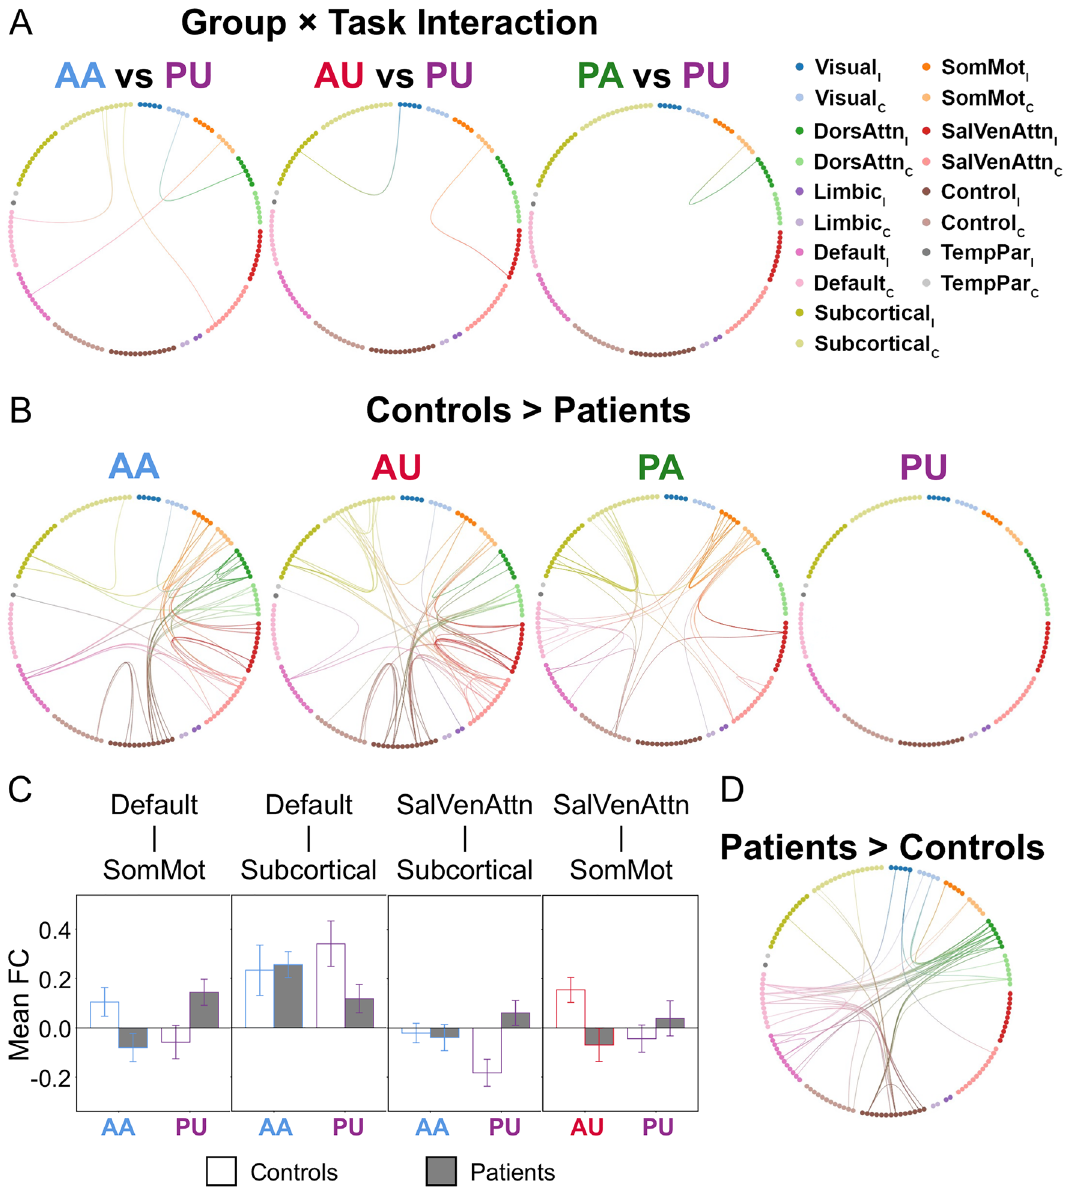
Figure 2. Disrupted intra- and inter-network functional connectivity at different task demands in stroke patients. ( A ) Significant group and task interaction effects were found between AA/AU/PA and PU. ( B ) Compared to age-matched healthy controls, stroke patients showed more disrupted intra- and inter-network FC during AA, AU, and PA tasks. During AA, stroke patients demonstrated lower FC in ipsilesional default as well as bilateral control, SalVenAttn, DorsAttn, SomMot, and subcortical networks. Remarkably, stroke patients presented additionally lower DorsAttn intra-network FC in AA compared to other tasks. Along with the decremental task demands, stroke patients showed less aberrant intra- and inter-network FC disruption. ( C ) The average FC of edges showing significant interaction effects for four representative networks impaired in stroke patients based on NBS statistics in panel ( A ) were shown. ( D ) Especially for the AA task, stroke patients showed more anti-correlation than healthy controls in default, control, and DorsAttn networks. Data are presented as mean ± standard error, AA active-affected, AU active-unaffected, C contralesional, DorsAttn dorsal attention, FC functional connectivity, I ipsilesional, NBS network-based statistics, PA passive-affected, PU passive-unaffected, SalVenAttn salience/ventral attention, SomMot somatomotor, TempPar